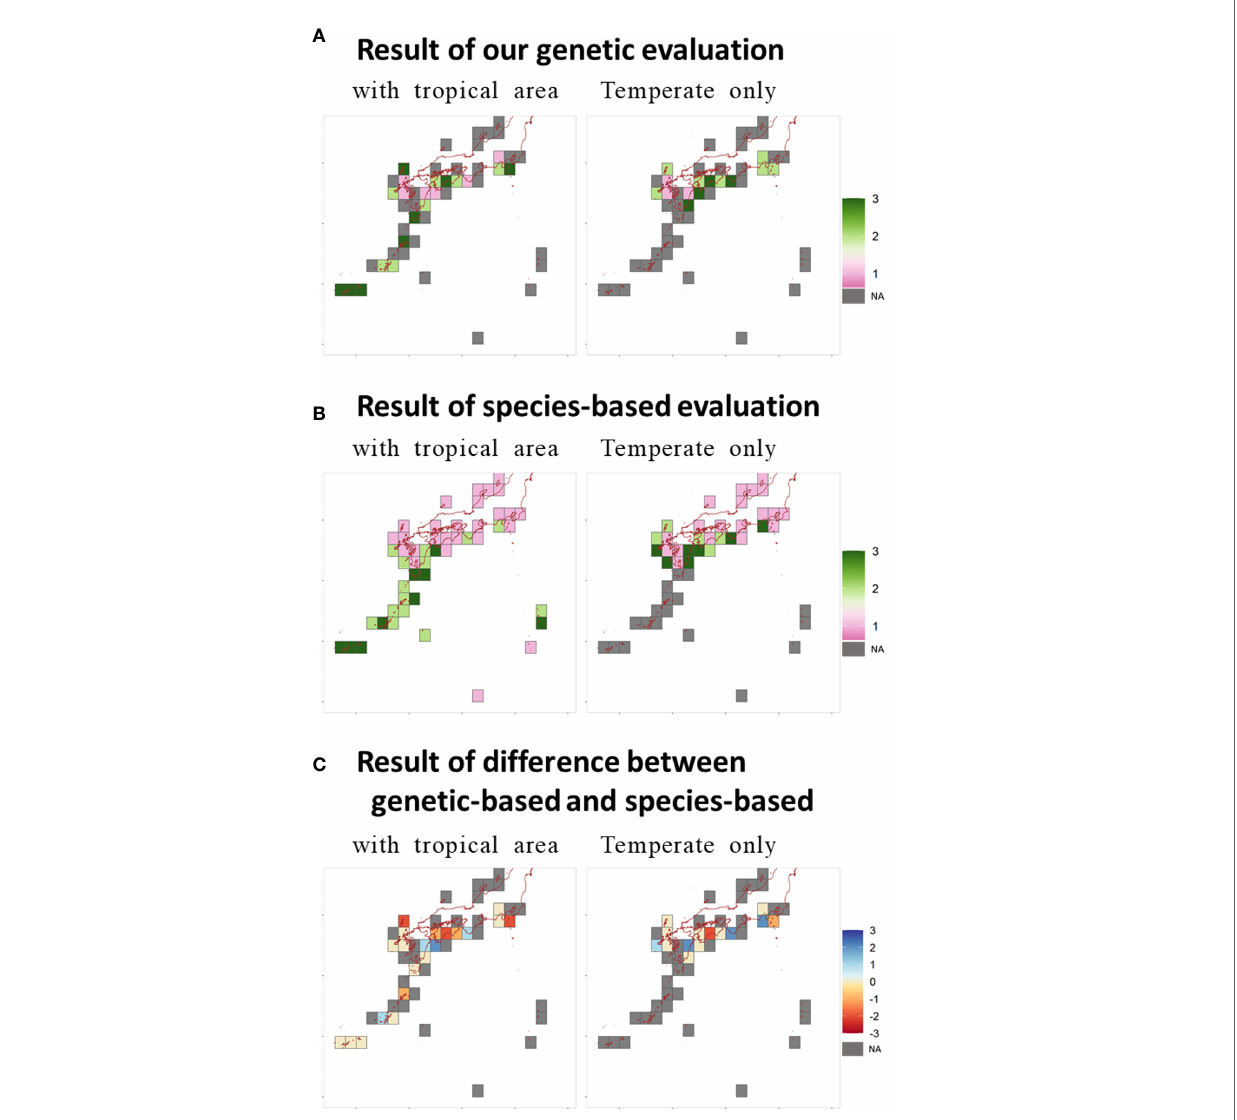
FIGURE 3 | Distribution of results for (A) integrated result for all criteria, (B) integrated result for all criteria for species-based evaluation, and (C) difference between genetic and species-based evaluation. NA, not